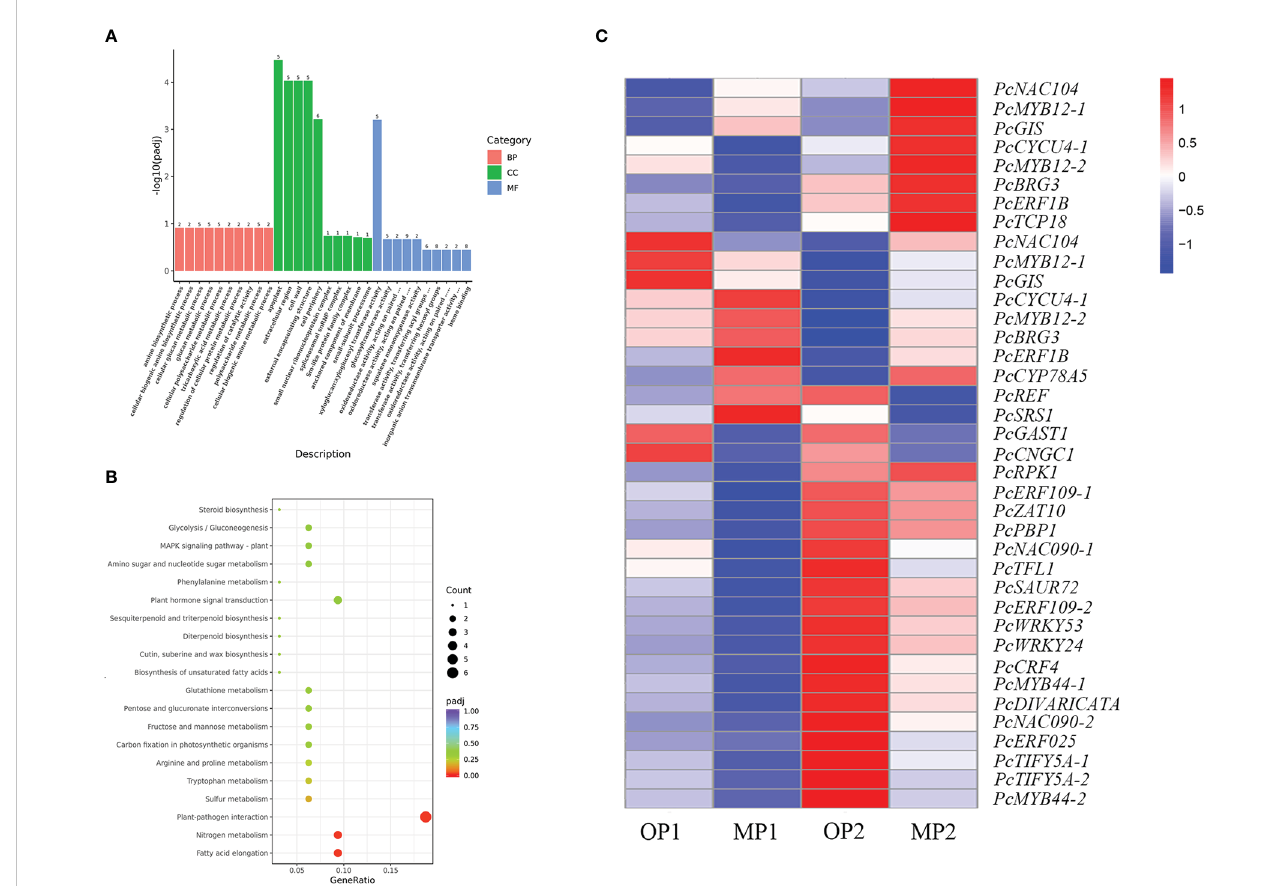
FIGURE 4 Functional annotation of differentially expressed genes (DEGs) in the mutant (MP) and wild type (OP). (A) DEGs enriched among the top 30 genes ontology terms. The annotated items are divided into three categories: cellular components(CC), molecular functions(MF), and biological processes(BP). (B) DEGs enriched among the top 20 KEGG pathways. (C) DEGs involved in cell division, differentiation, and shoot apical meristem activity, in which MP1 and OP1 were the shoot dormancy, MP2 and OP2 were the bud expanding stage. FPKM values are log 2